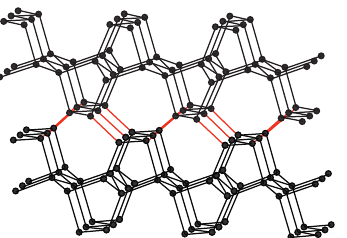
Figure 5: The structure M [ 3 , 3 , 2 ] . The connection of two layers. Bonding is shown is red color.